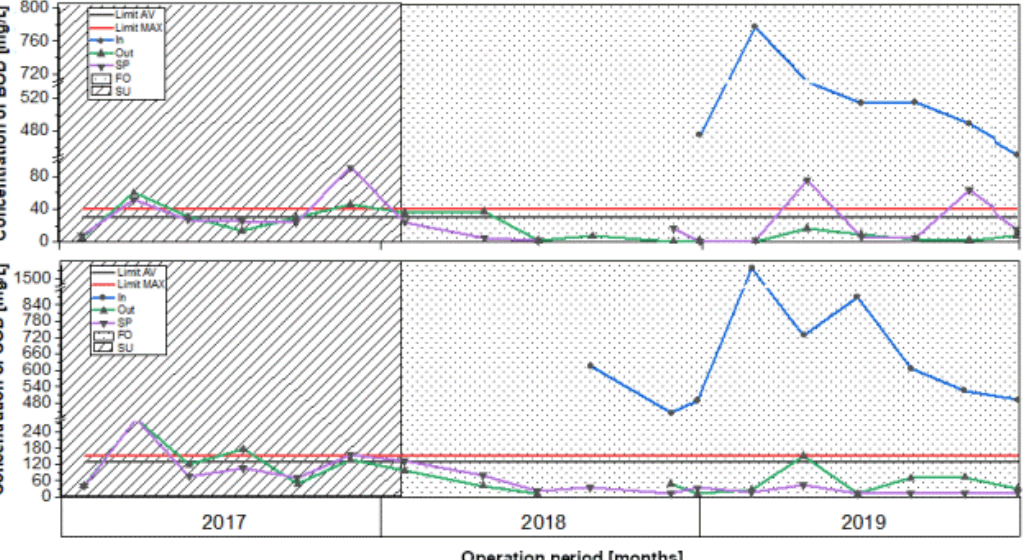
Figure 2. BOD 5 ( upper ) and COD ( lower ) concentration development. AV = average limit, MAX = maximal limit, In = inlet, Out = outlet, SP = stabilization pond, FO = full operation, SU = start-up phase.